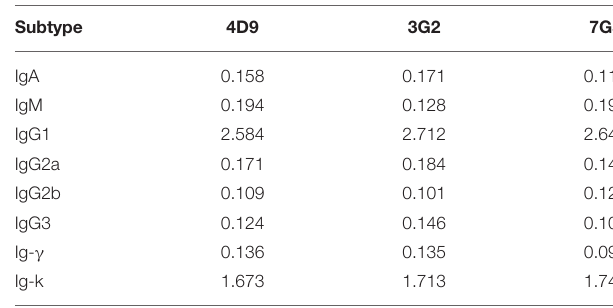
TABLE 1 | Subtype identification of the monoclonal